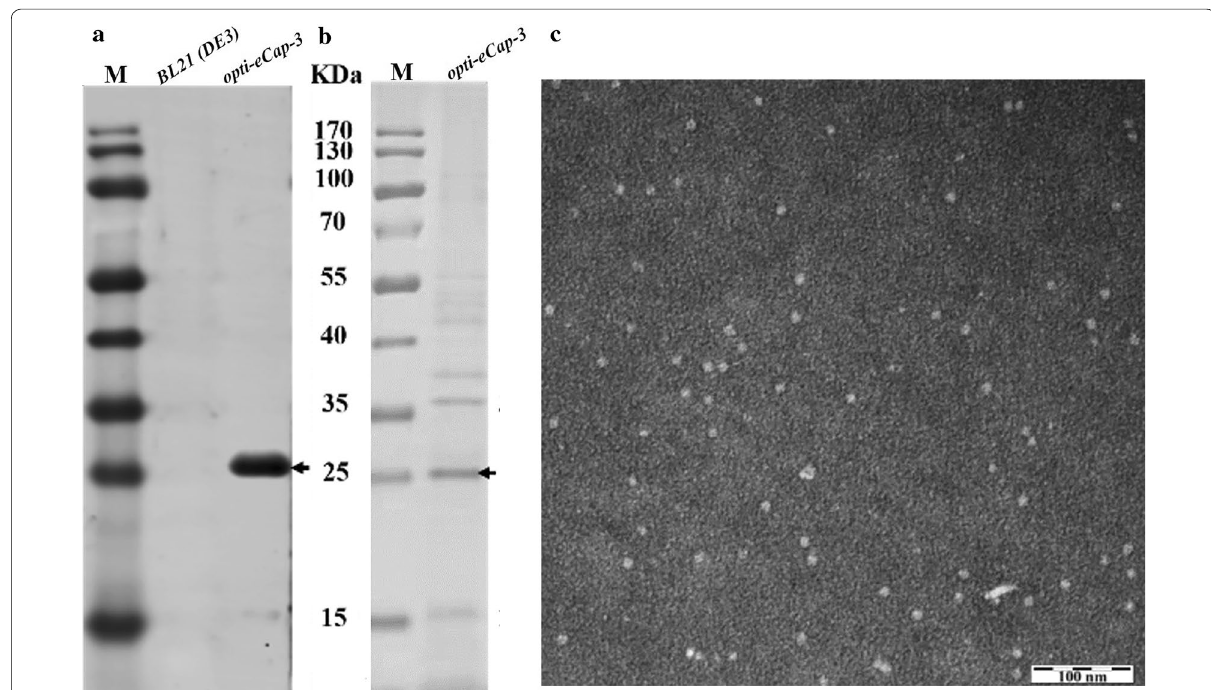
Fig. 3 Analysis and purification of opti‑eCap‑3. a Western blots with swine PCV3‑specific positive serum. b SDS‑PAGE result and c TEM images of